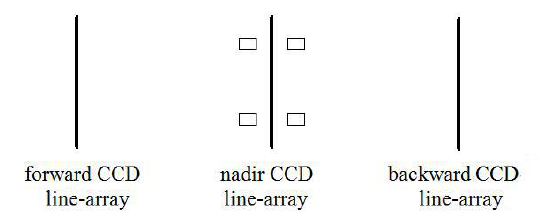
Figure 3. Relationship between three-line arrays and four matrix arrays